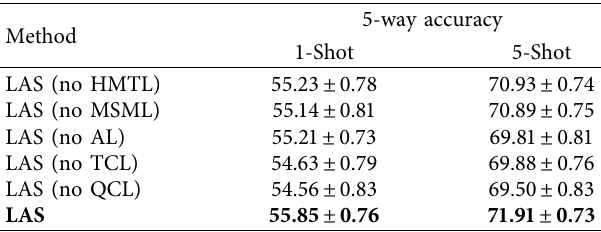
Table 2: Mean accuracy (%) ± CIs (%) of 4 state-of-the-art methods, the 5 sublosses, and LAS on the CIFAR-100